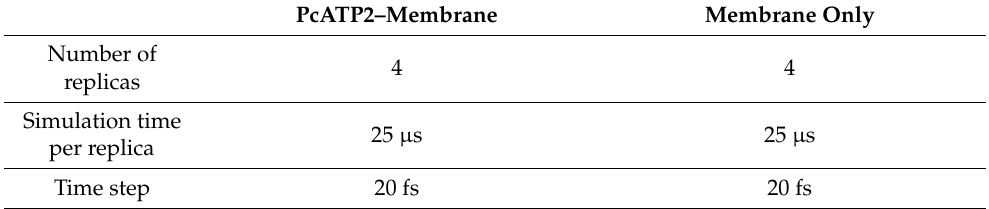
Table 1. System initial set-up information, simulation conditions, and membrane composition. PcATP2–Membrane Membrane